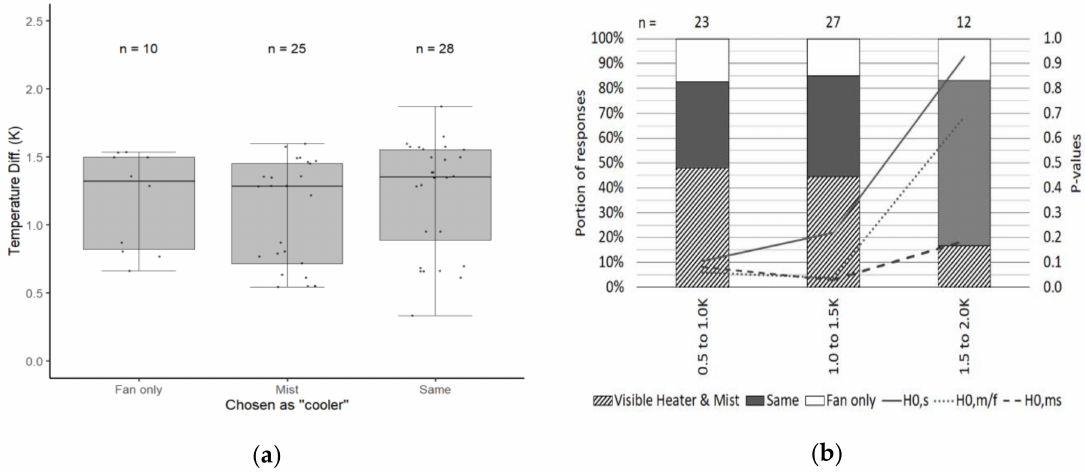
Figure 11. Distribution of temperature differences ( a ) and responses ( b ) from the second supplemental trial, Trial 5.